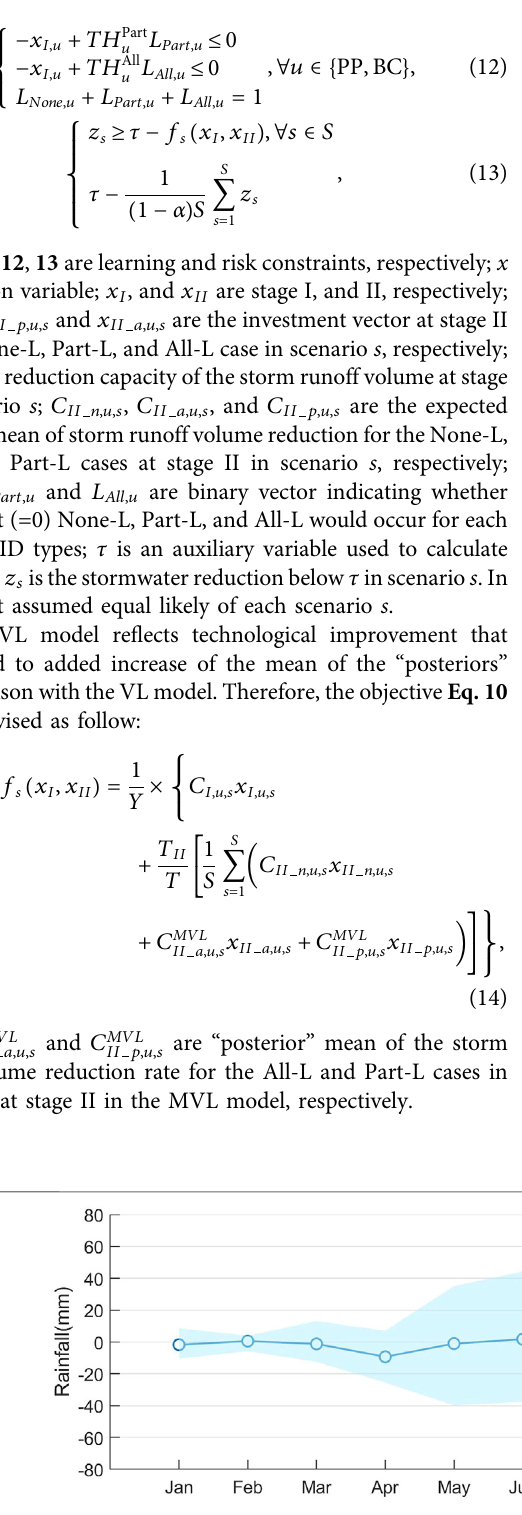
Frontiers in Environmental Science |